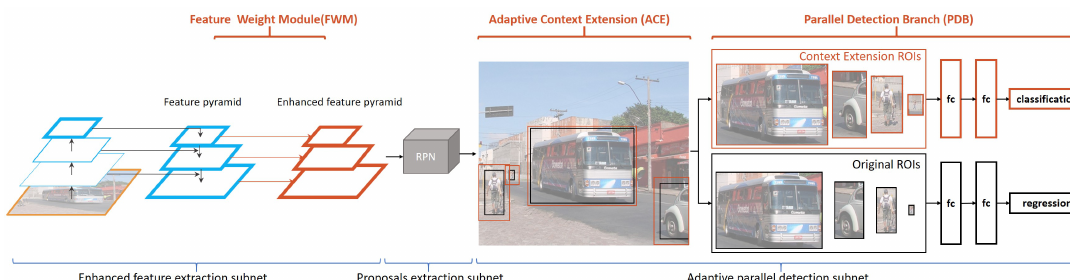
Figure 1. The structure of